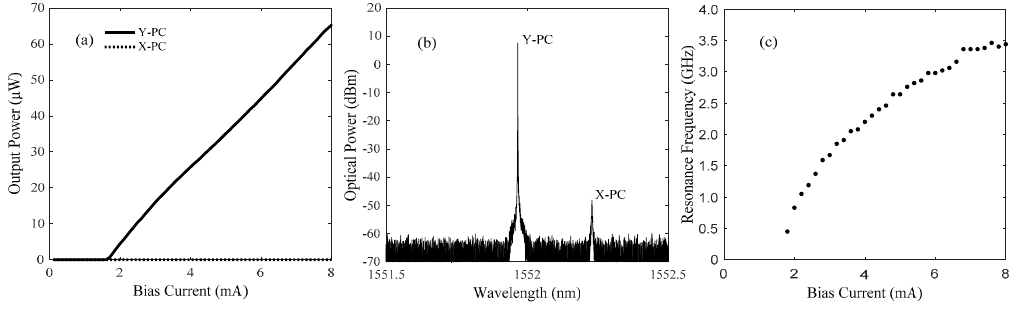
Figure 2. Experimentally measured ( a ) polarization-resolved P - I curve, ( b ) optical spectrum of the free-running 1550 nm VCSEL biased at 5.0 mA, ( c ) F r- I curve.